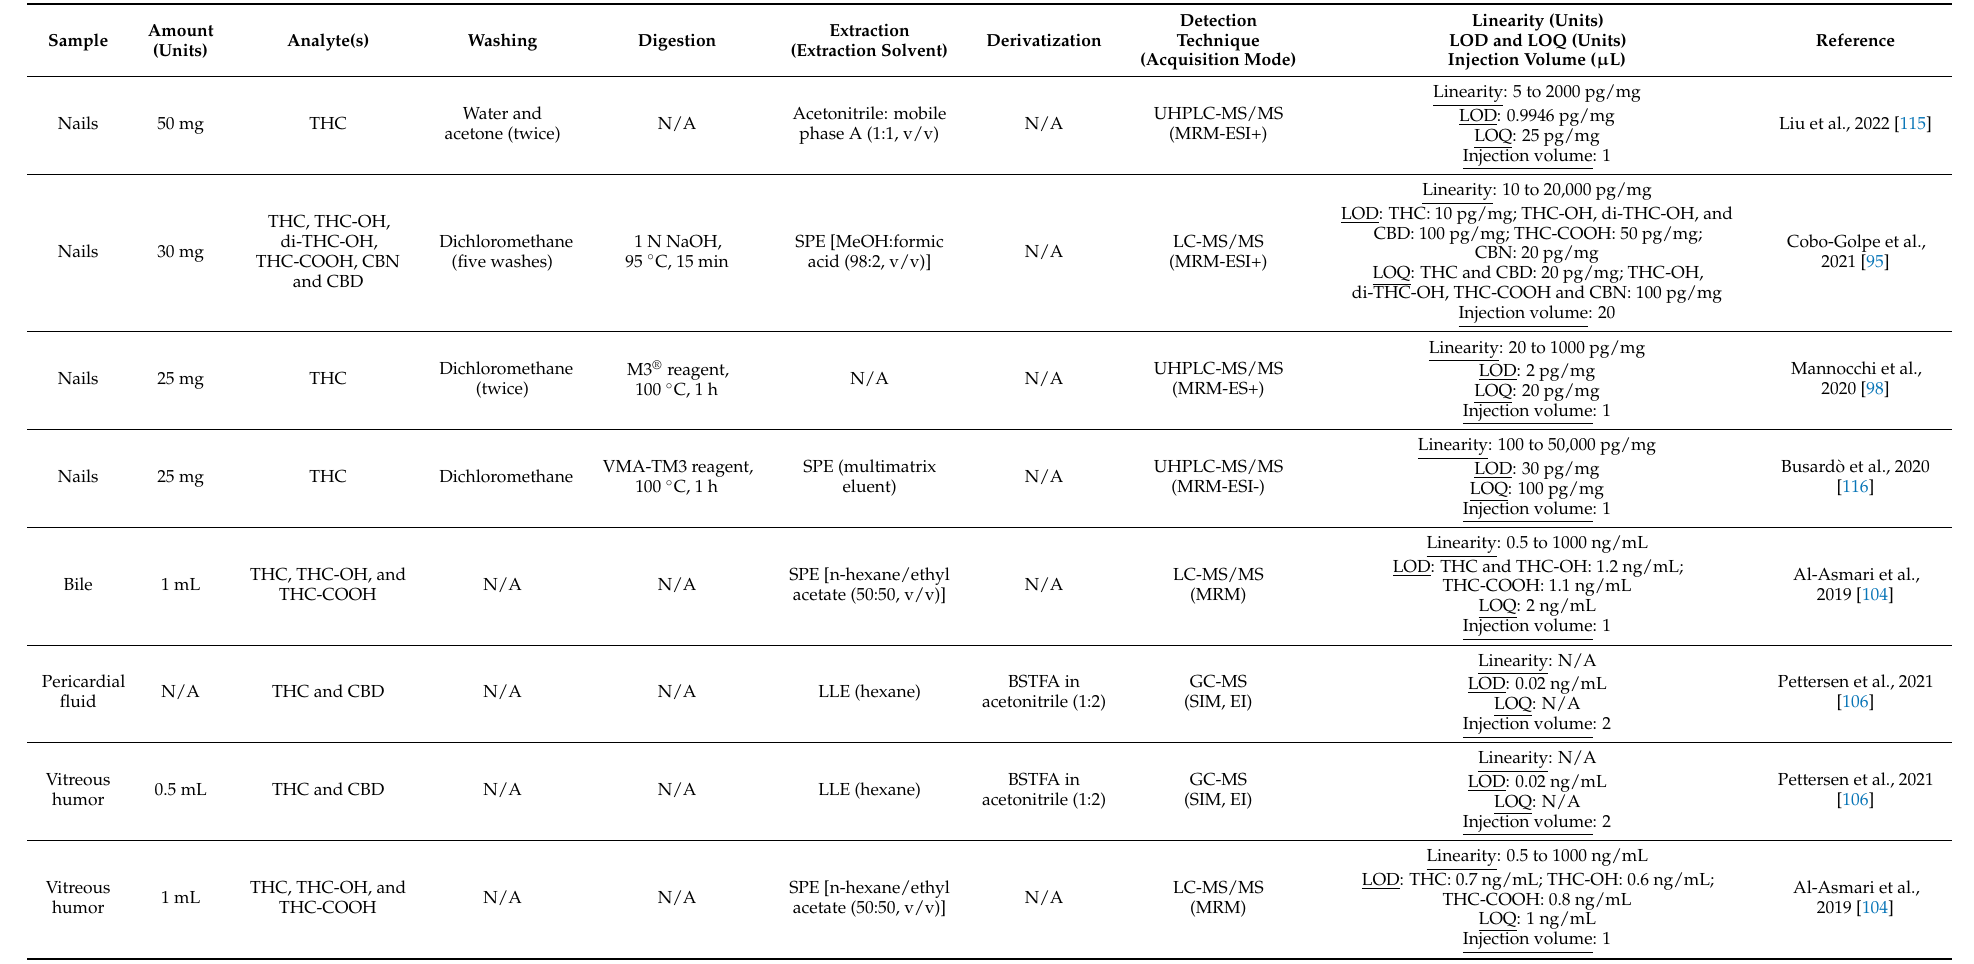
Table 7. Methods for the identification and quantification of cannabinoids in other unconventional biological